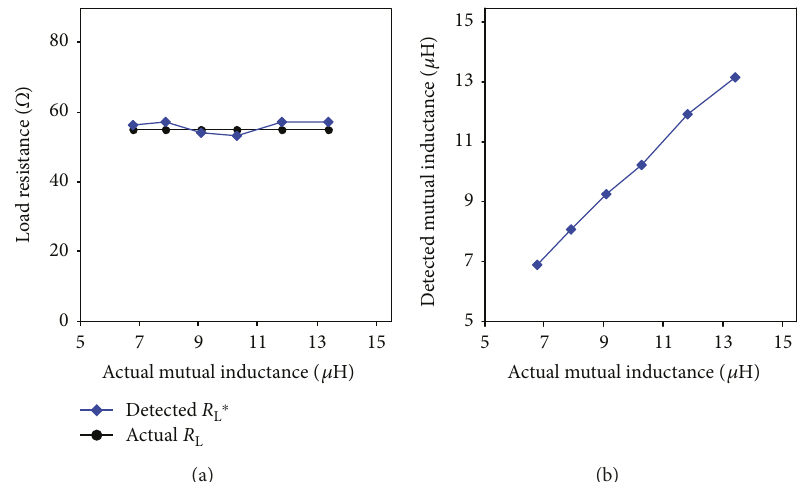
Figure 4: Detected results of (a) load resistance and (b) mutual inductance when actual mutual inductance